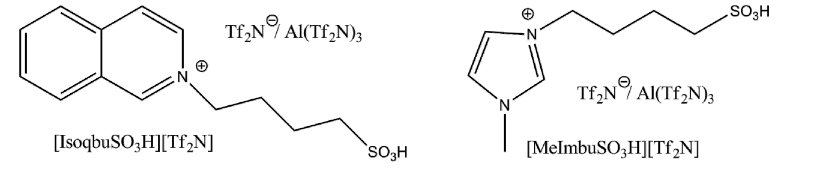
Figure 6. Brønsted/Lewis acidic ILs mixtures.